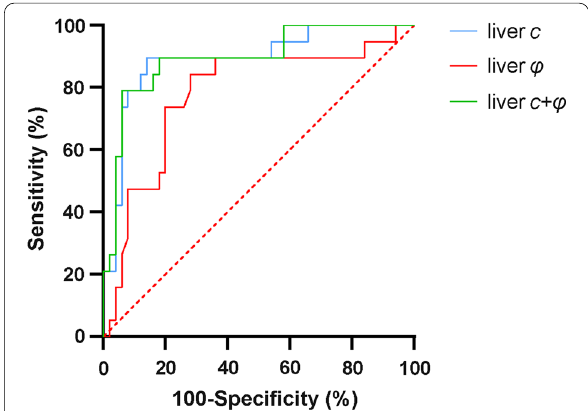
Fig. 5 Liver c , liver φ and their combination for detecting an ICG-R15 > 14%. ICG-R15: 15-min indocyanine green retention